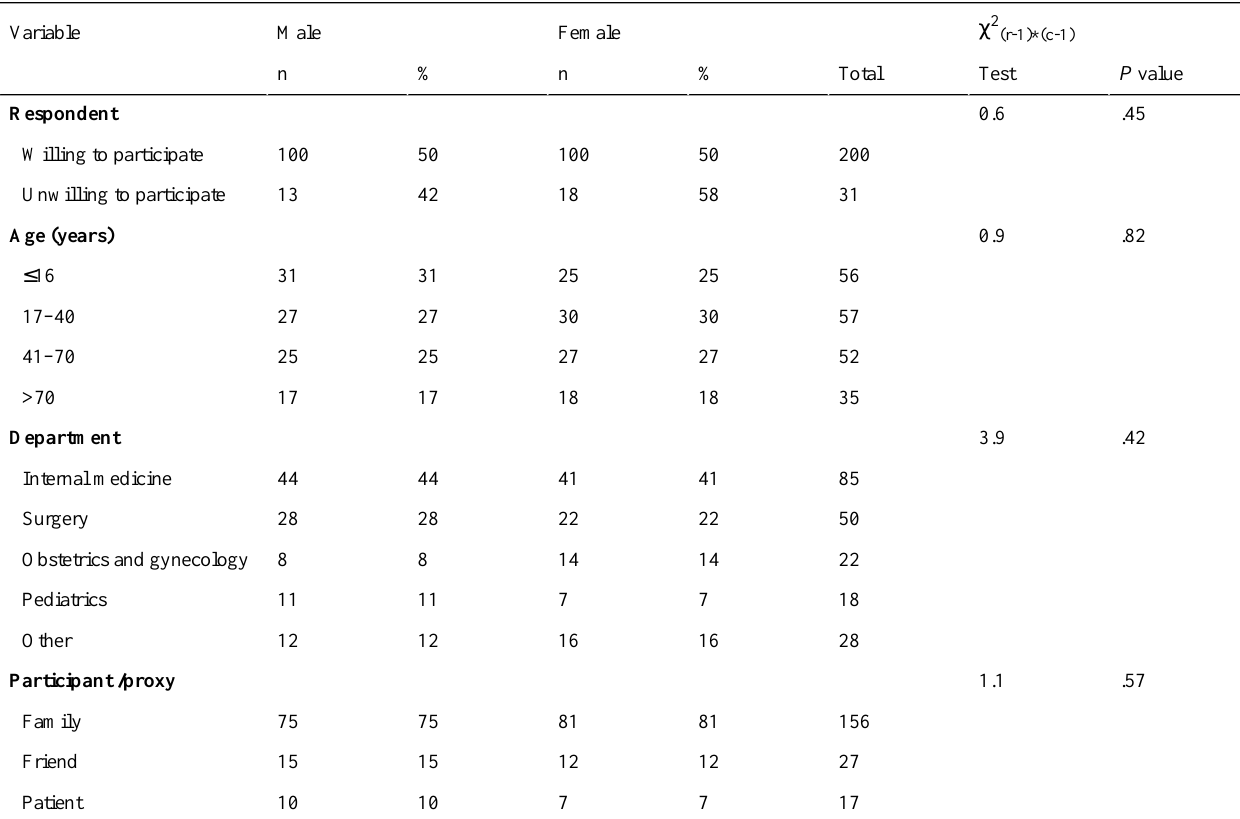
Table 2. Demographic characteristics of the study population (N = 200)